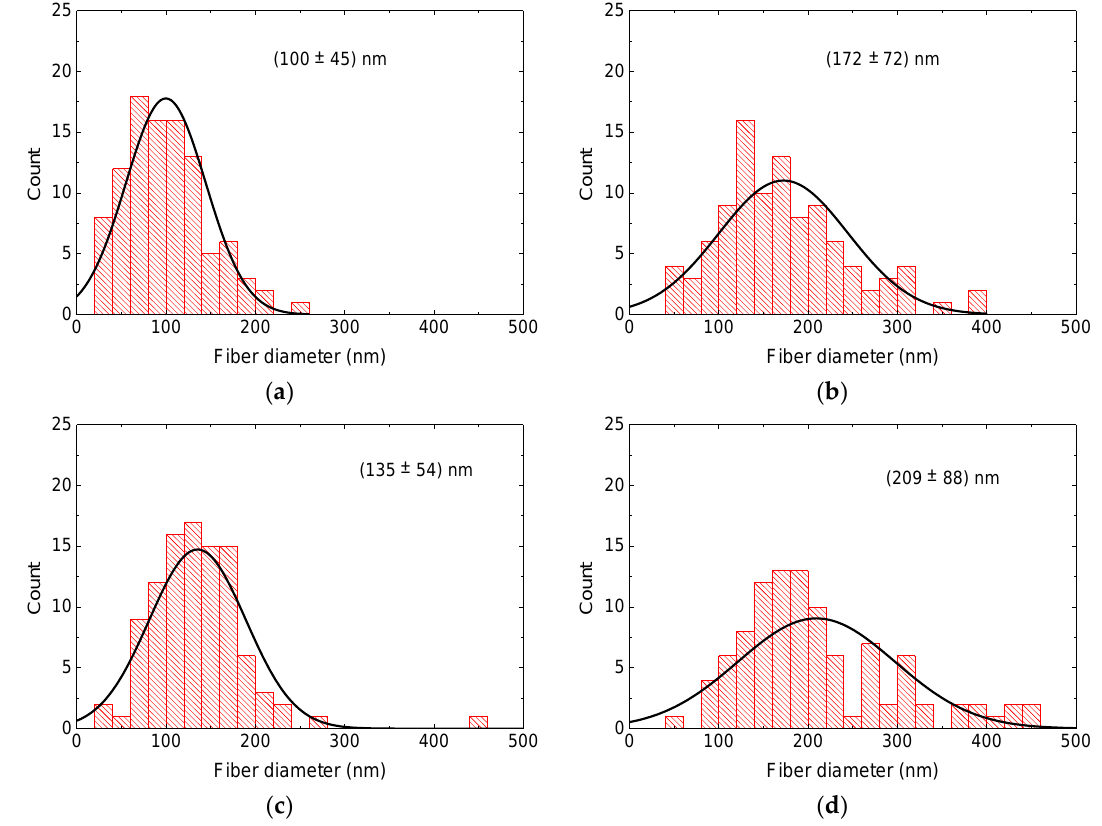
Figure 4. Distributions of the diameters of PAN / magnetite nanofibers: ( a ) after electrospinning; ( b ) after stabilization; ( c ) after carbonization at 500 °C; ( d ) after carbonization at 800 °C.